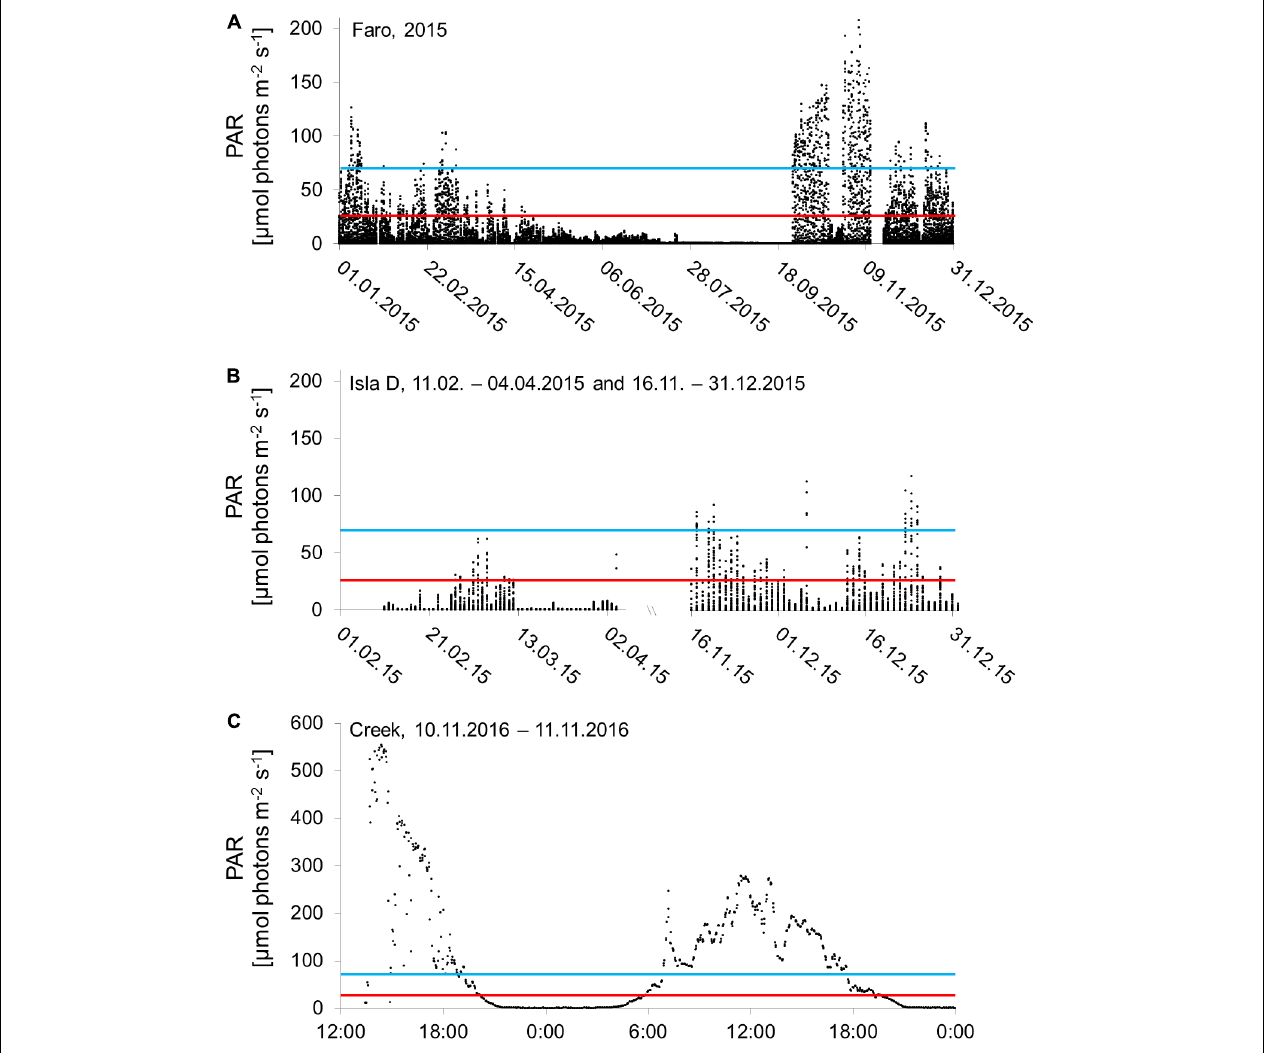
FIGURE 2 | In situ measured photosynthetically active radiation intensities (PAR) on a seasonal scale at (A) Faro (entire year 2015), (B) and Isla D (February 11, 2015–April 4, 2015 and November 16, 2015–December 31, 2015), and on a daily scale at (C) Creek (November 10, 2016–November 11, 2016). The red line marks the light compensation point of 26 µ mol photons m – 2 s – 1 and the bright blue line the maximum PAR used during the experiment presented in this study.